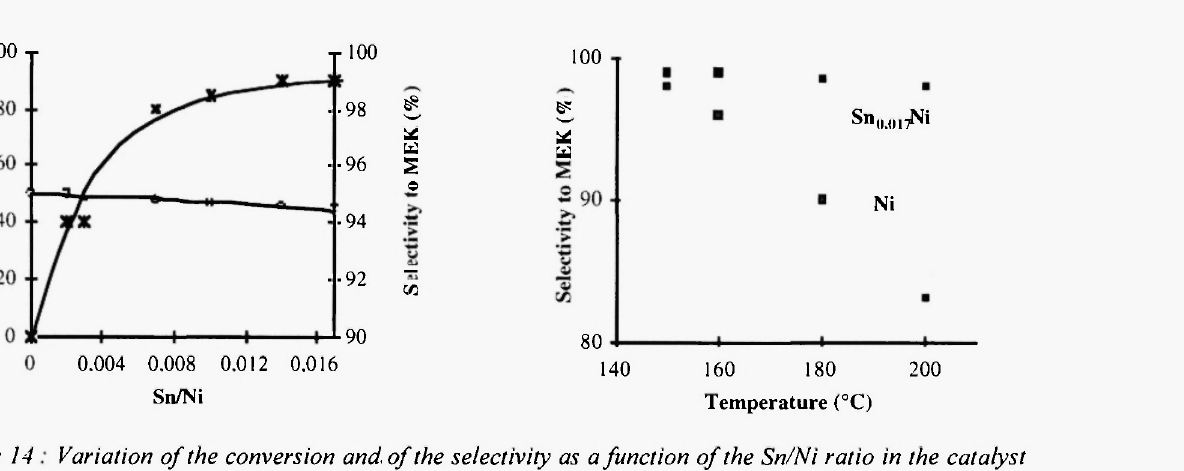
Figure 14 Variation of the conversion and of the selectivity as a function of the Sn/Ni ratio in the catalyst (left) and of the reaction temperature (right). Alloy effect: dehydrogenation of isobutane into